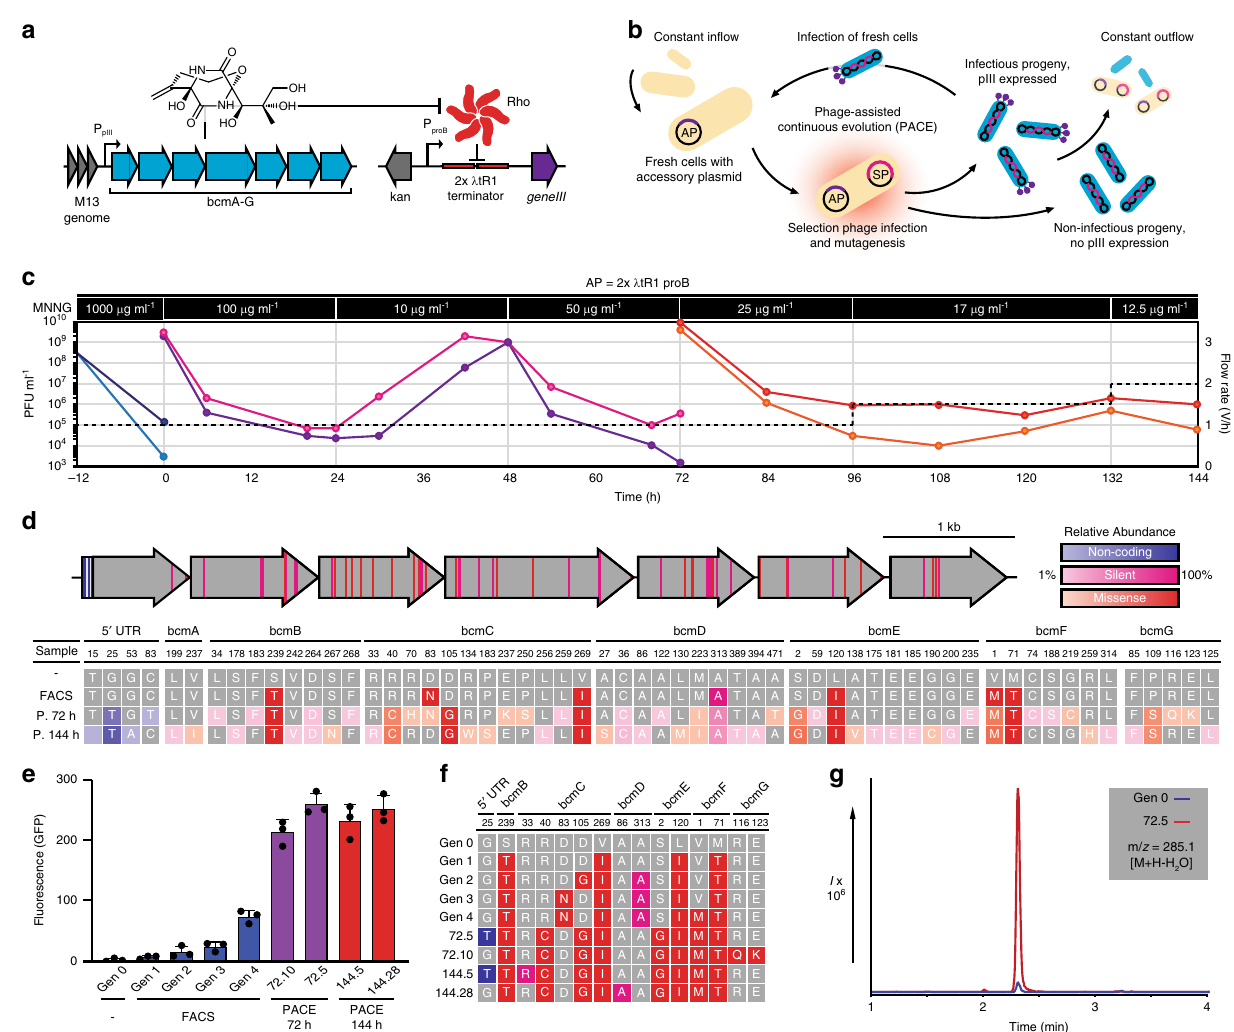
Fig. 2 Bioactivity-dependent continuous evolution of the P. aeruginosa BCM BGC. a Accessory plasmid and genetic circuit design for bioactivity-dependent expression of geneIII . b Schematic representation of PACE. E. coli cells carrying an accessory plasmid (AP; purple) encoding geneIII are provided continuously from a chemostat to fi xed-volume lagoons inoculated with selection phage (SP; blue). Only functional SPs can propagate and persist within the lagoon under continuous dilution. Lagoons are supplemented with a chemical mutagen to facilitate mutagenesis at 30°C. c SP BCM titers (plaque forming units; PFU) over 144h of PACE, reporting values for duplicate lagoons. Concentrations of the mutagen 1-methyl-3-nitro-1-nitrosoguanidine (MNNG) are indicated for each segment, along with lagoon fl ow rates (dashed lines). d Summary of mutations accumulated during BCM operon evolution. Below, relative abundance of each mutation is depicted. e Activity of wild-type and evolved BCM operons against the stringent reporter pREP.2 (Supplementary Fig. 1). Shown as mean±s.d.; n = 3 biological replicates. f Genotypes of tested BCM variants. A legend for color coding can be found in d . g LC/MS extracted ion chromatograms of the dominant bicyclomycin parent ion (an in-source decay water loss, m/z = 285.1 [M + H – H 2 O]) from culture supernatants of the original BCM operon (Gen 0) and a PACE-evolved variant (72.5). Source data underlying c , e are available as a Source Data fi